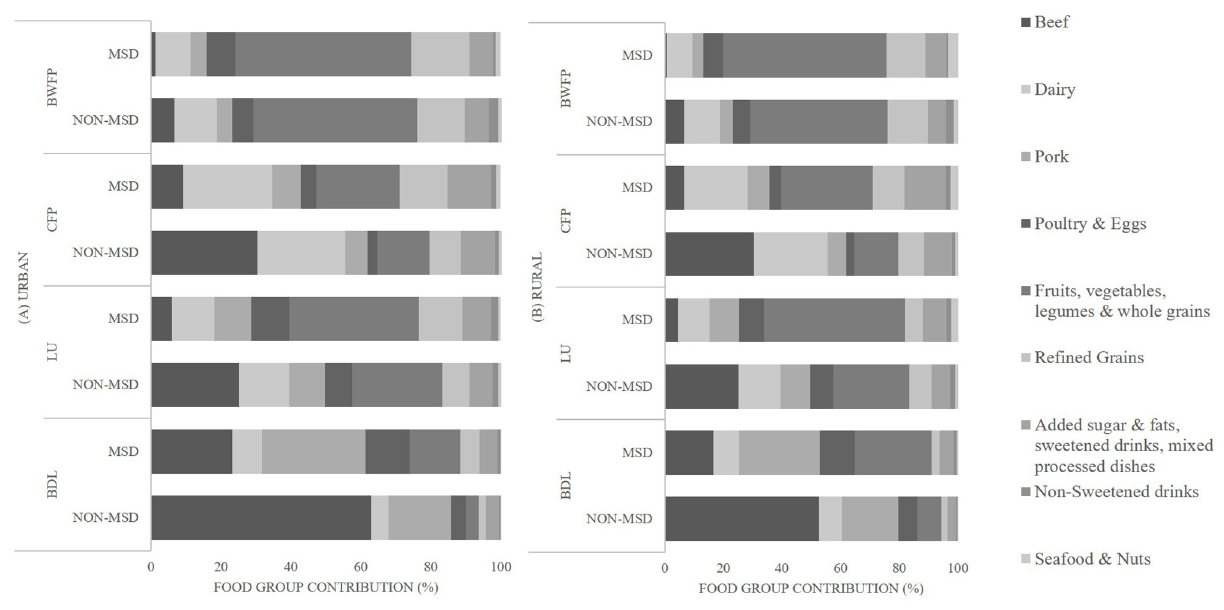
Frontiers in Nutrition |